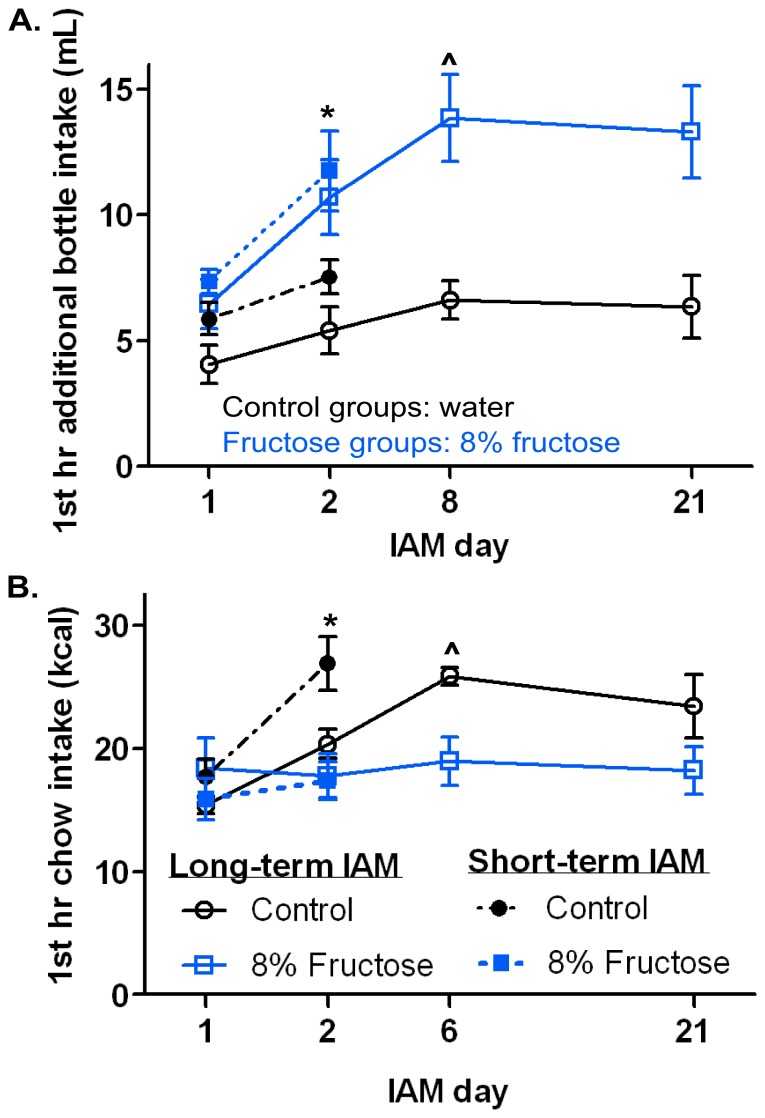
Both long- and short-term IAM produced similar levels of bingeing behavior.
A: 1st hr water (black symbols; control) or fructose (blue symbols; 8% fructose) intake on days 1 and 2 for the short-term IAM experiment (closed symbols) and on days 1, 2, 8 and 21 for the long-term IAM experiment (open symbols). B: 1st hr chow intake on days 1 and 2 of short-term IAM and days 1, 2, 6, and 21 of long-term IAM. ∧ denotes the day at which stable fructose or chow bingeing was achieved in the long-term IAM experiment. *p<0.05 paired t-test short-term IAM only. Mean values ± SEM (n = 8/group).